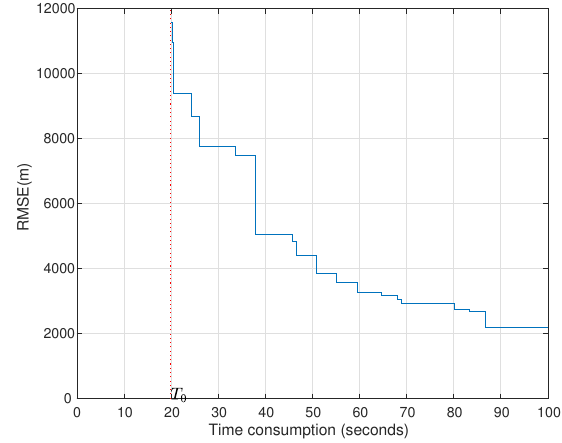
Figure 14. Positioning accuracies and time consumptions of MP-ML.